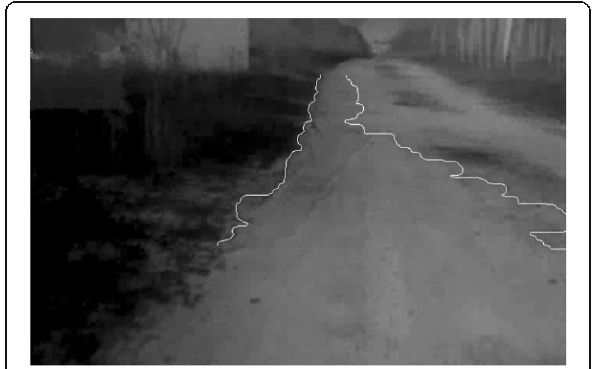
Fig. 10 FCM clustering result based on trapezoid prediction model